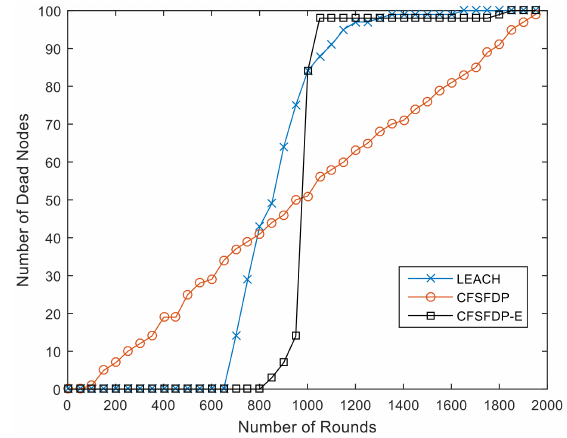
Figure 3. Network lifetime comparison of LEACH, CFSFDP and CFSFDP-E.